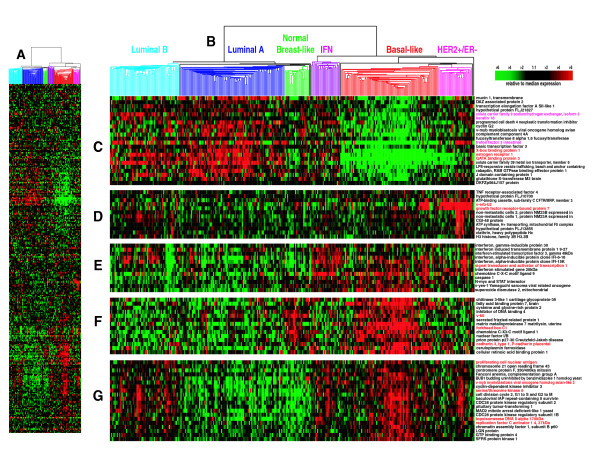
Hierarchical cluster analysis of the 315-sample combined test set using the Intrinsic/UNC gene set reduced to 306 genes. (A) Overview of complete cluster diagram. (B) Experimental sample-associated dendrogram. (C) Luminal/ER+ gene cluster with GATA3-regulated genes highlighted in pink. (D) HER2 and GRB7-containing expression cluster. (E) Interferon-regulated cluster containing STAT1. (F) Basal epithelial cluster. (G) Proliferation cluster.